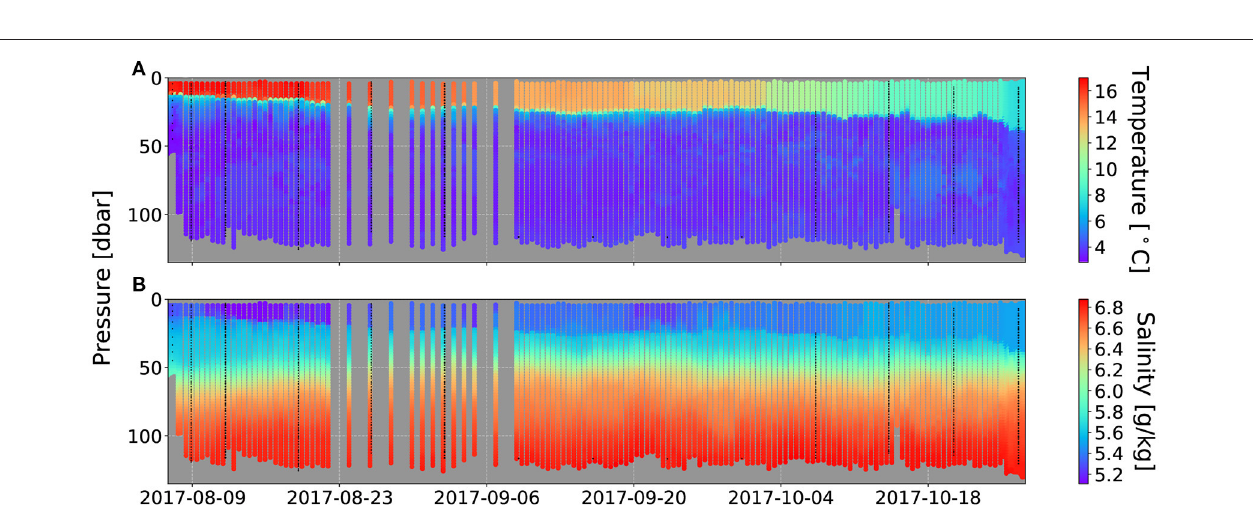
FIGURE 7 | (A) Temperature and (B) absolute salinity profiles from float 6902029. Black dotted lines show timing of profiles of float 6902028 during the same period. The gray shade is the background color and indicates that no data is